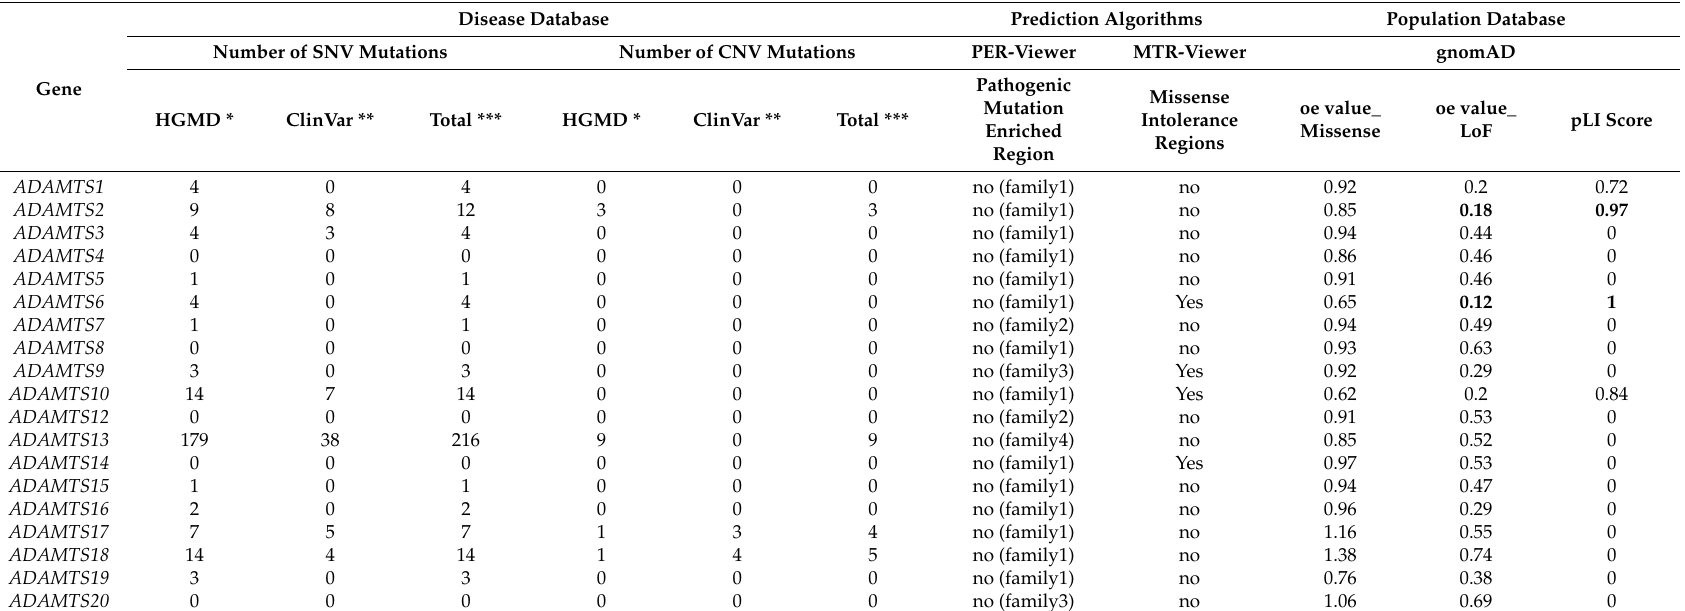
Table 3. Mutational spectrum of ADAMTS family genes in Mendelian hereditary disorders in current databases and literature. Disease Database Prediction Gene